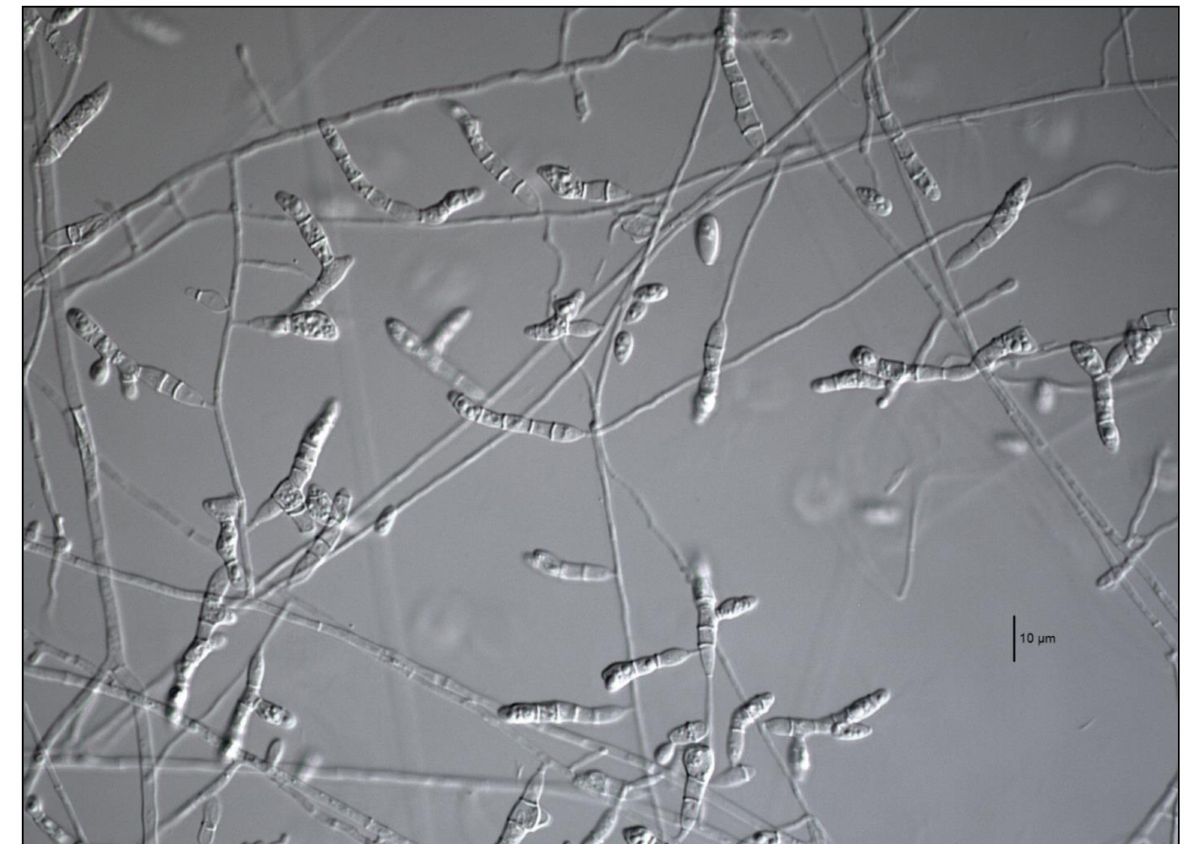
Figure 3. Scedosporium aurantiacum DMic 175588. Polycytella-like asexual morph. Bar = 10 µ